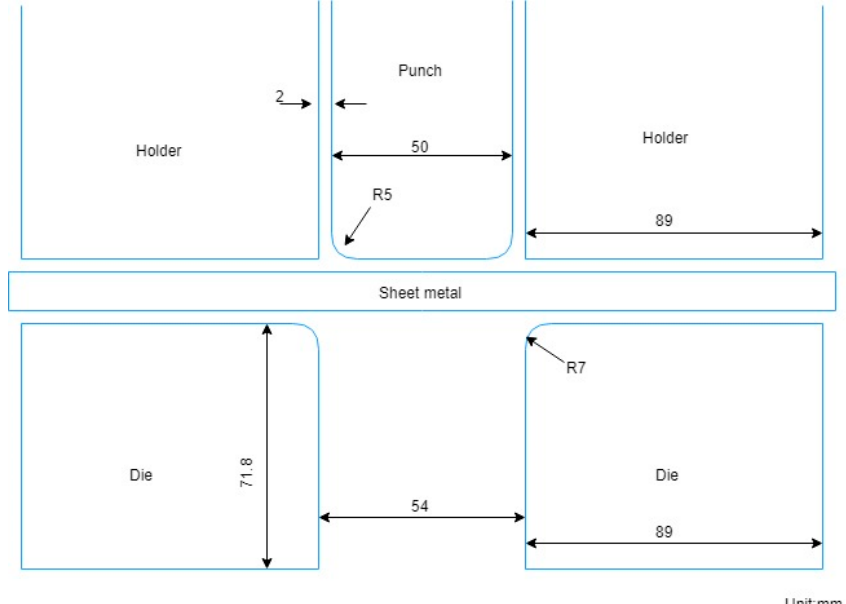
Figure 2. Dimensions of the punch, die, and holder of U-draw bending.